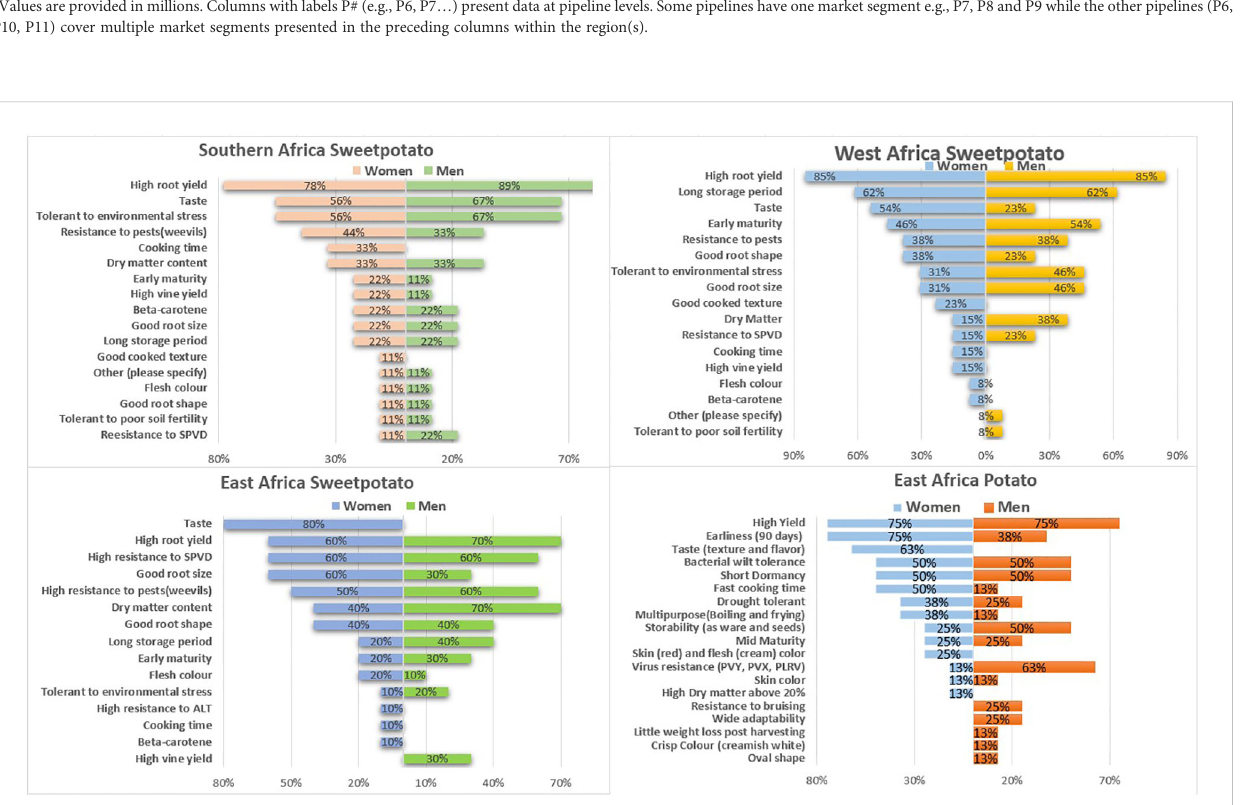
FIGURE 3 Stakeholders perception of major sweetpotato and potato traits preferred by women and men in the